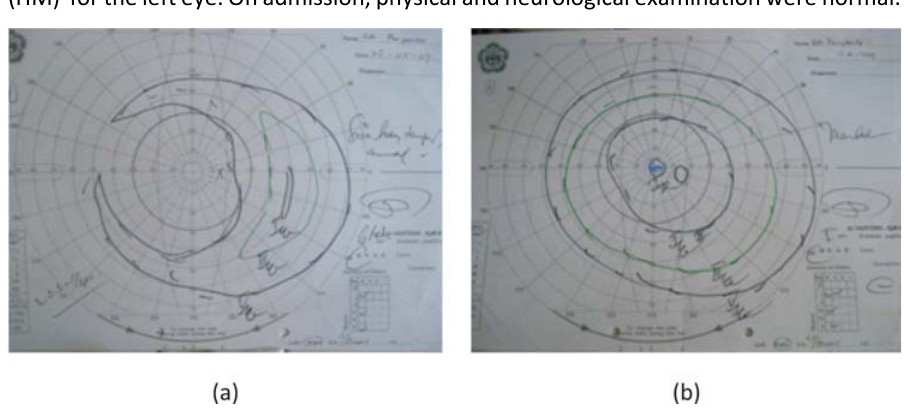
Figure 2. Visual field examination with Goldman perimetry: (a) taken at first visit. The result was minimal temporal remnant for the rignt eye and could not be performed for the left eye, (b) taken after 1 month treatment. The result was